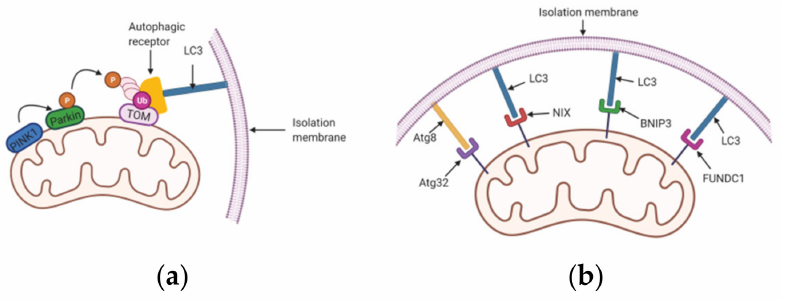
Figure 1. The PINK1/Parkin and ubiquitin-independent pathways of mitophagy. This figure was created with BioRender.com. ( a ) PINK1 accumulates on the damaged mitochondria and recruits E3 ligase Parkin. Autophagic cargo receptors recognize phosphorylated poly-Ub chains catalyzed by activated PINK1 and Parkin, thereby facilitating the mitochondria into autophagosomes fusing with a lysosome, causing degradation of mitochondria. ( b ) The ubiquitin-independent pathways are mediated by mitophagy receptors Atg32, NIX, BNIP3, and FUNDC1, etc. In yeast cells, OMM protein Atg32 binds to Atg8 on the depolarized mitochondrial membrane via its WXXL-like Atg8-binding motif and eliminates unwanted mitochondria. In mammalian cells, mitophagy receptors NIX, BNIP3, and FUNDC1 directly interact with LC3 through the LIR motif to mediate